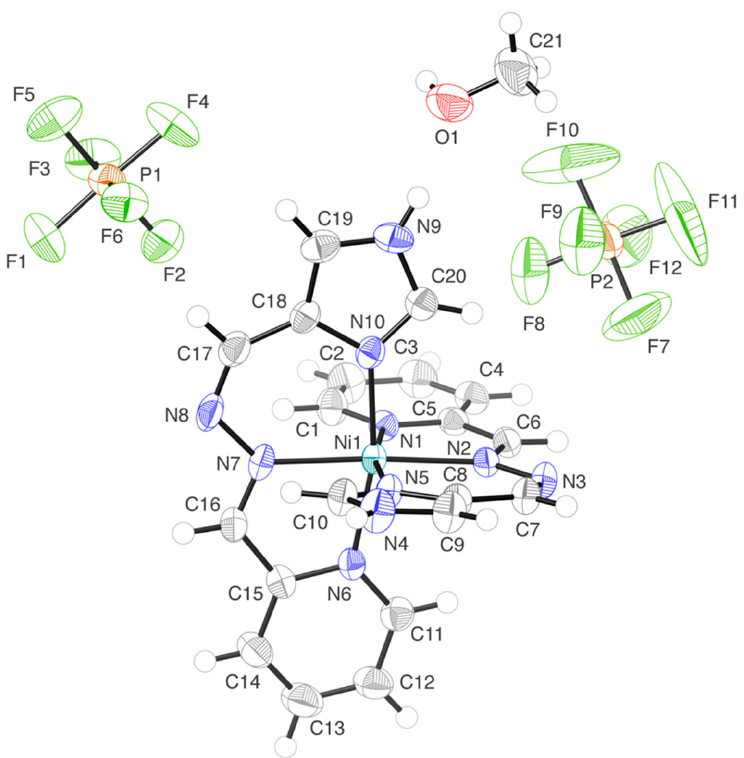
Figure 1. An ORTEP drawing of [Ni(HL H ) 2 ](PF 6 ) 2 · MeOH ( 1 · MeOH) with an atom-numbering scheme (ellipsoids are drawing at a 50% probability level).